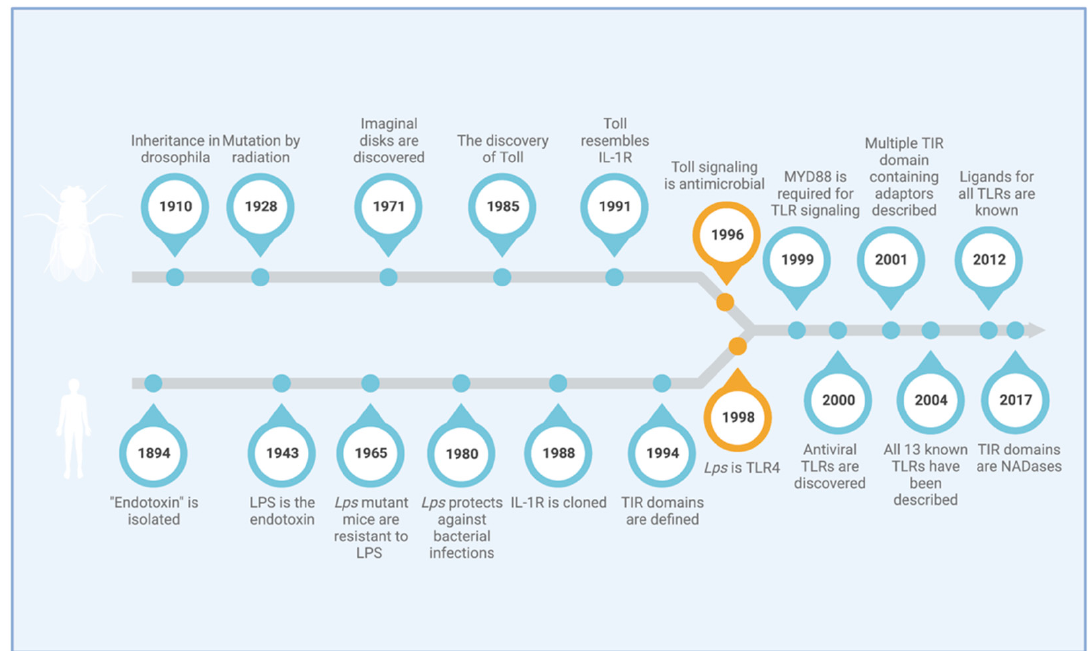
Figure 1. Milestones along the way to TLR discovery. The highlighted publications contributed significantly to today’s knowledge on TLRs and innate immunity.